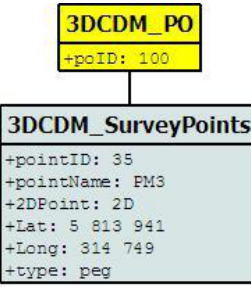
Figure 21. Instance of 3DCDM_SurveyPoints Package